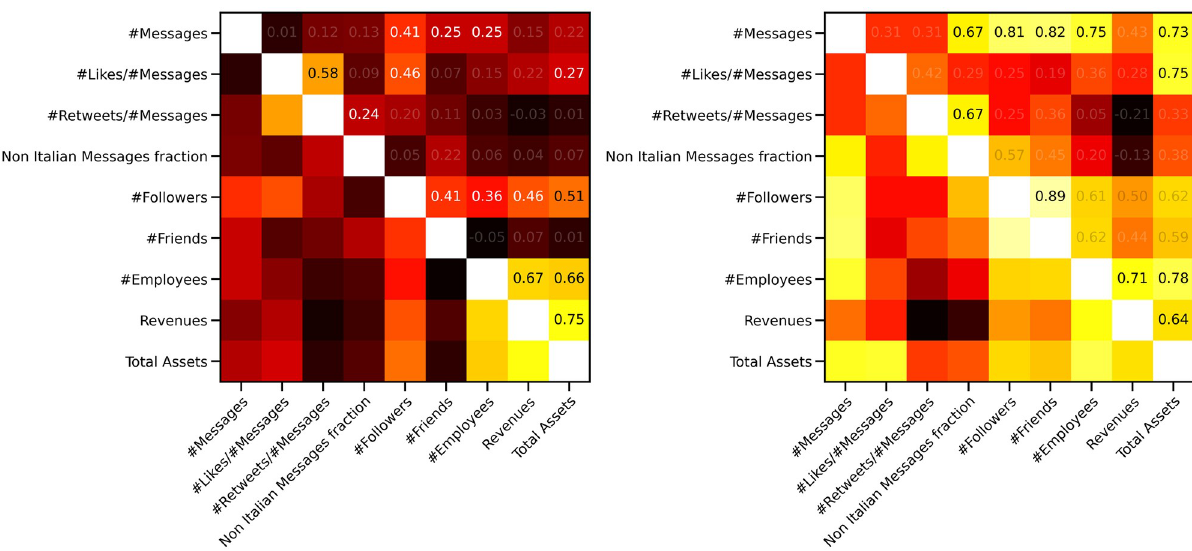
Fig 4. Spearman correlations among different financial and online data for firms in the validated network. On the left panel the correlation matrix for the validated network: all correlations between online and financial quantities are weak, as in the entire data set (see left panel of Fig 1), but for the one between the number of followers and the total assets (0.51). Again, the situation changes once we focus on a specific ATECO code and it is even more striking than for the entire data set (see left panel of Fig 1). In fact, the same correlation matrix for sector 62 ( Computer programming, consultancy and related activitie ) shows a strong correlation, for instance, between the total number of messages and the total assets (0.73) and between the number of Likes per message and the total assets (0.75). In fact, the validated accounts are those that follow a common strategy in the usage of hashtags and the importance of their appearance online increases relatively to the dimension of the